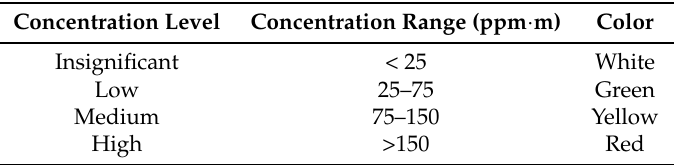
Table 5. Methane concentration thresholds.